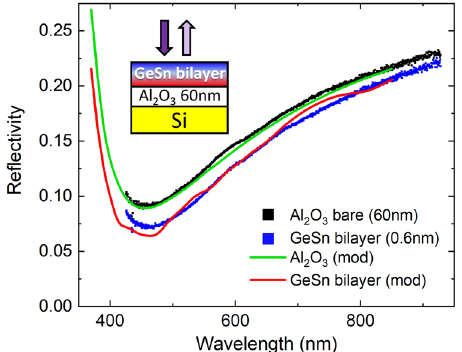
Fig. 5 Experimental and computed optical re fl ectivity. Ellipsome- try measurements of the optical re fl ectivity (dots) in the wavelength range of 400 – 950nm for the 60 nm thick Al 2 O 3 substrate deposited on Si bulk (black) and the GeSn bilayer grown on top of the substrate (blue). The modelled re fl ectivity, obtained using a combination of ab-initio and transfer matrix methods (solid lines), is shown in green and red for the bare substrate and the GeSn bilayer,